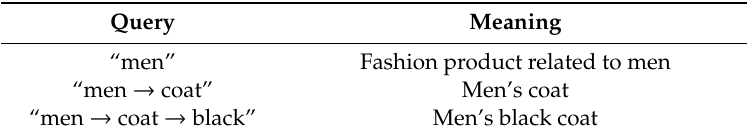
Table 2. Query examples using the category form. The query scope is confined to the order of gender, clothes, color, etc. “ → ” represents the sub-category.